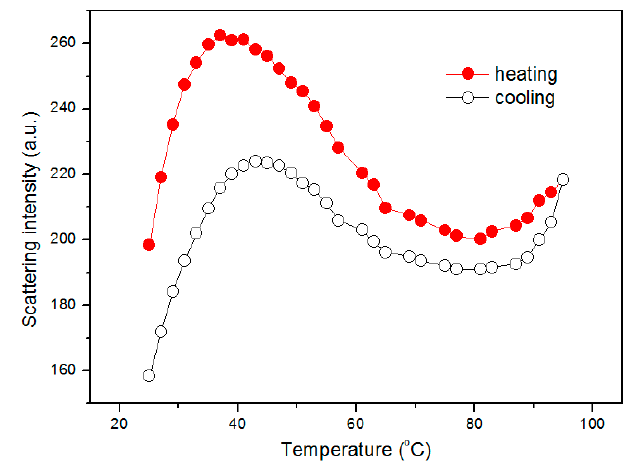
Figure 6. Scattering intensity of 0.13 g · L − 1 mPEG-maleic rosin solution at 390 nm as a function of temperature during heating and cooling process.